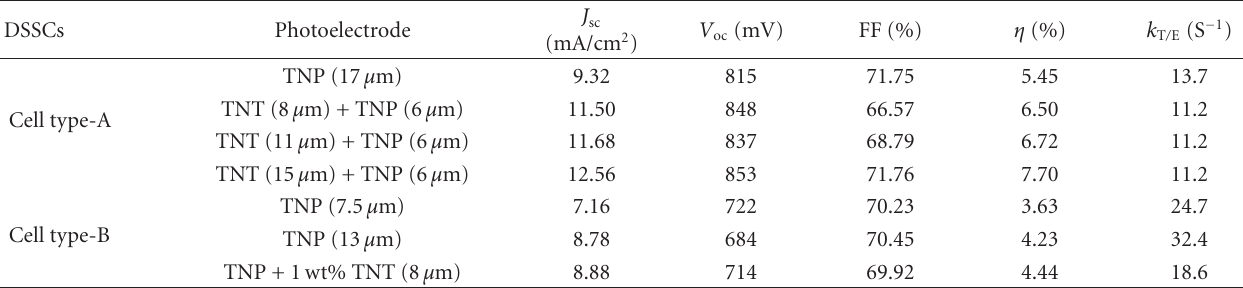
Table 1: Photovoltaic and kinetic parameters of cell type-A, and cell type-B based DSSCs. DSSCs Photoelectrode